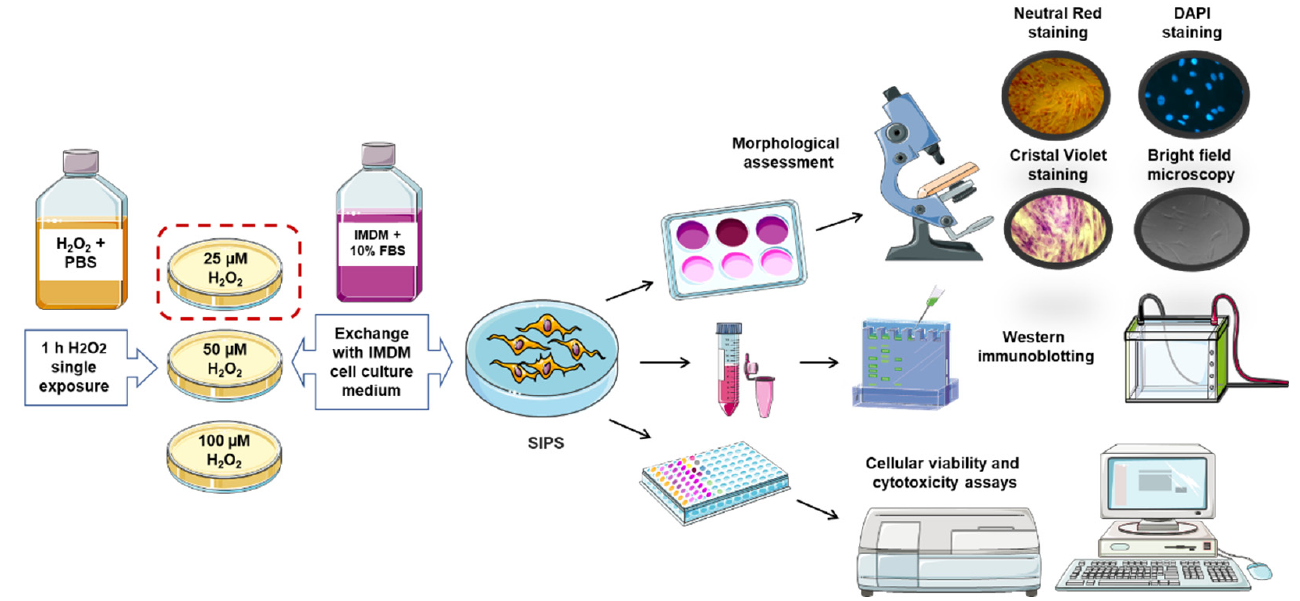
Figure 2. One-step model of hydrogen peroxide stimulated premature cellular senescence. SIPS, stress-induced premature senescence. Cultivated cells were treated with H 2 O 2 dissolved in PBS for one hour after 70% cell confluency was achieved. This figure was created using images from Servier Medical Art Commons Attribution 3.0 Unported License (http://smart.servier.com accessed on 26 September 2020).